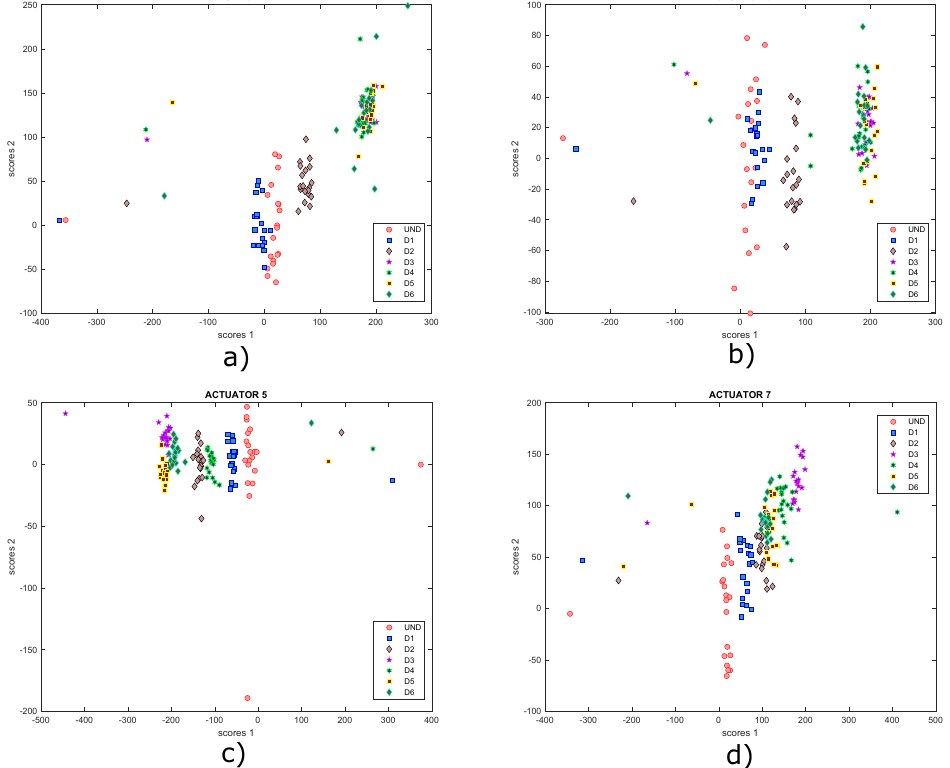
Figure 32. Graphs of scores 1 vs. scores 2 for actuation phases: ( a ) 1; ( b ) 3; ( c ) 5 and ( d )